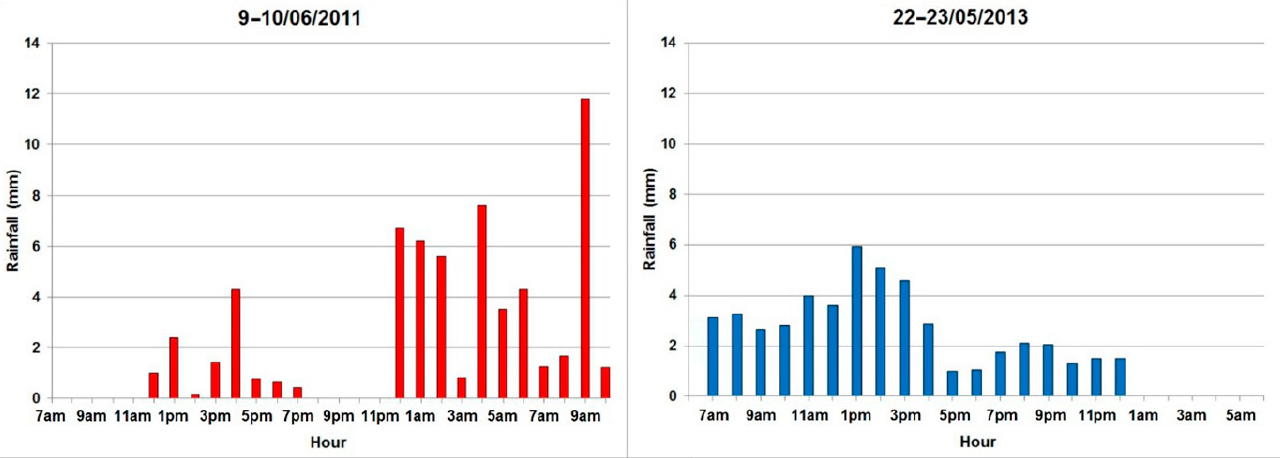
Figure 8. Areal average rainfall calculated from hourly rainfall maps available for 2011 ( left ) and 2013 ( right ) landslide events.